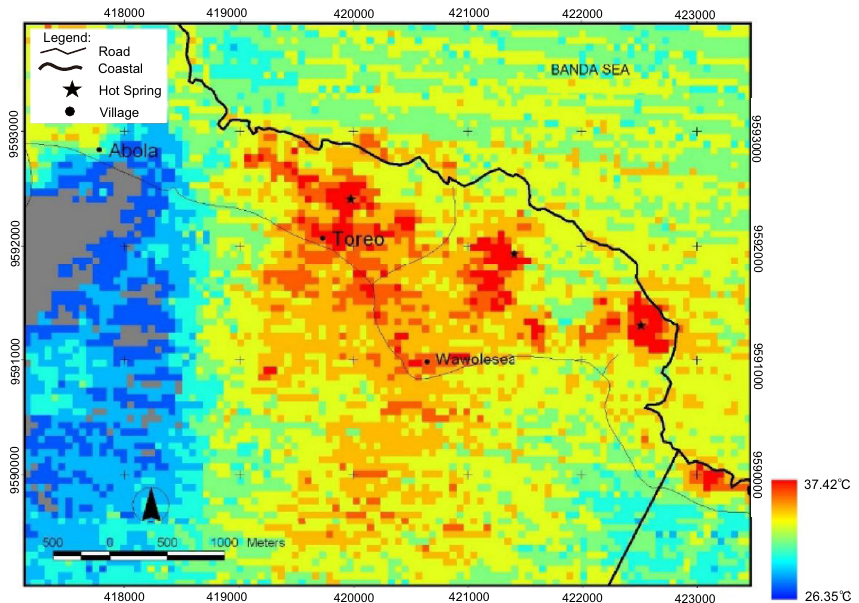
Fig. 4 LST map showing the anomaly of high surface temperature and geothermal manifestations in Toreo and Wawolesea (from Jaya et al. 2021)